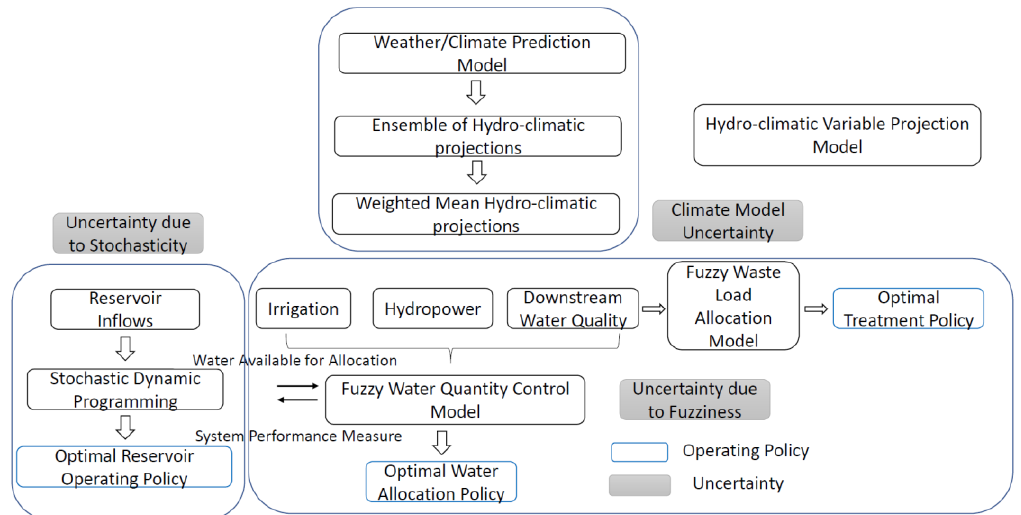
Figure 4. Basin-scale water resource systems modeling and associated uncertainties.